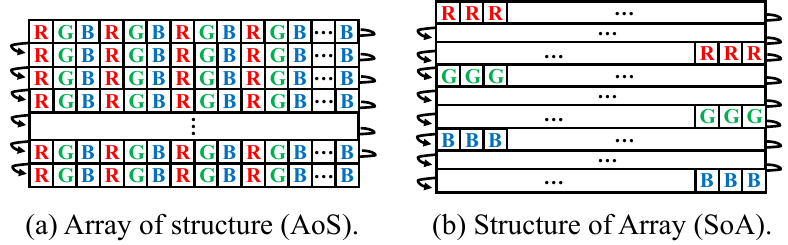
Figure 2. Image data structure: ( a ) Array of structure (AoS); ( b ) Structure of Array (SoA).